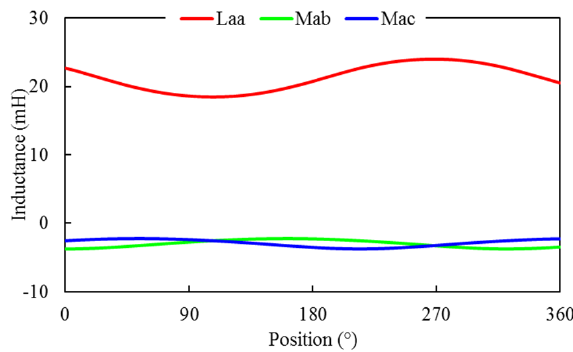
Figure 18. Comparisons of self- and mutual-inductances.